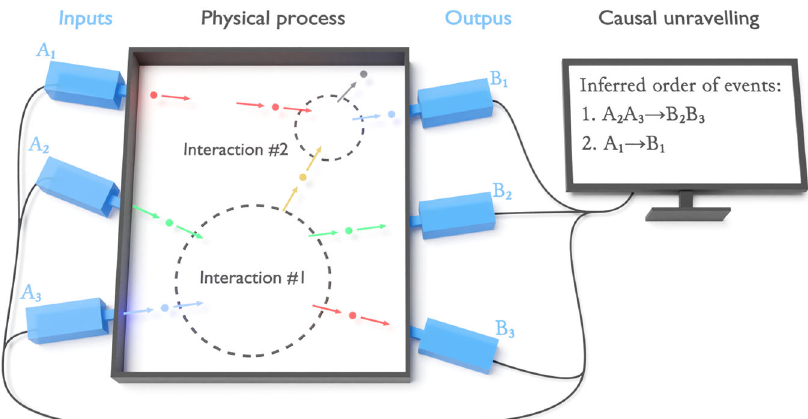
Fig. 1 Causal unravelling. A physical process involves a set of input systems (in the fi gure, A 1 , A 2 , and A 3 ) and a set of output systems (in the fi gure, B 1 , B 2 , and B 3 ). The process is the result of a sequence of interactions, each of which involves a subset of the inputs and a subset of the outputs. The problem is to infer the causal structure of the interactions solely from the input – output behaviour of the